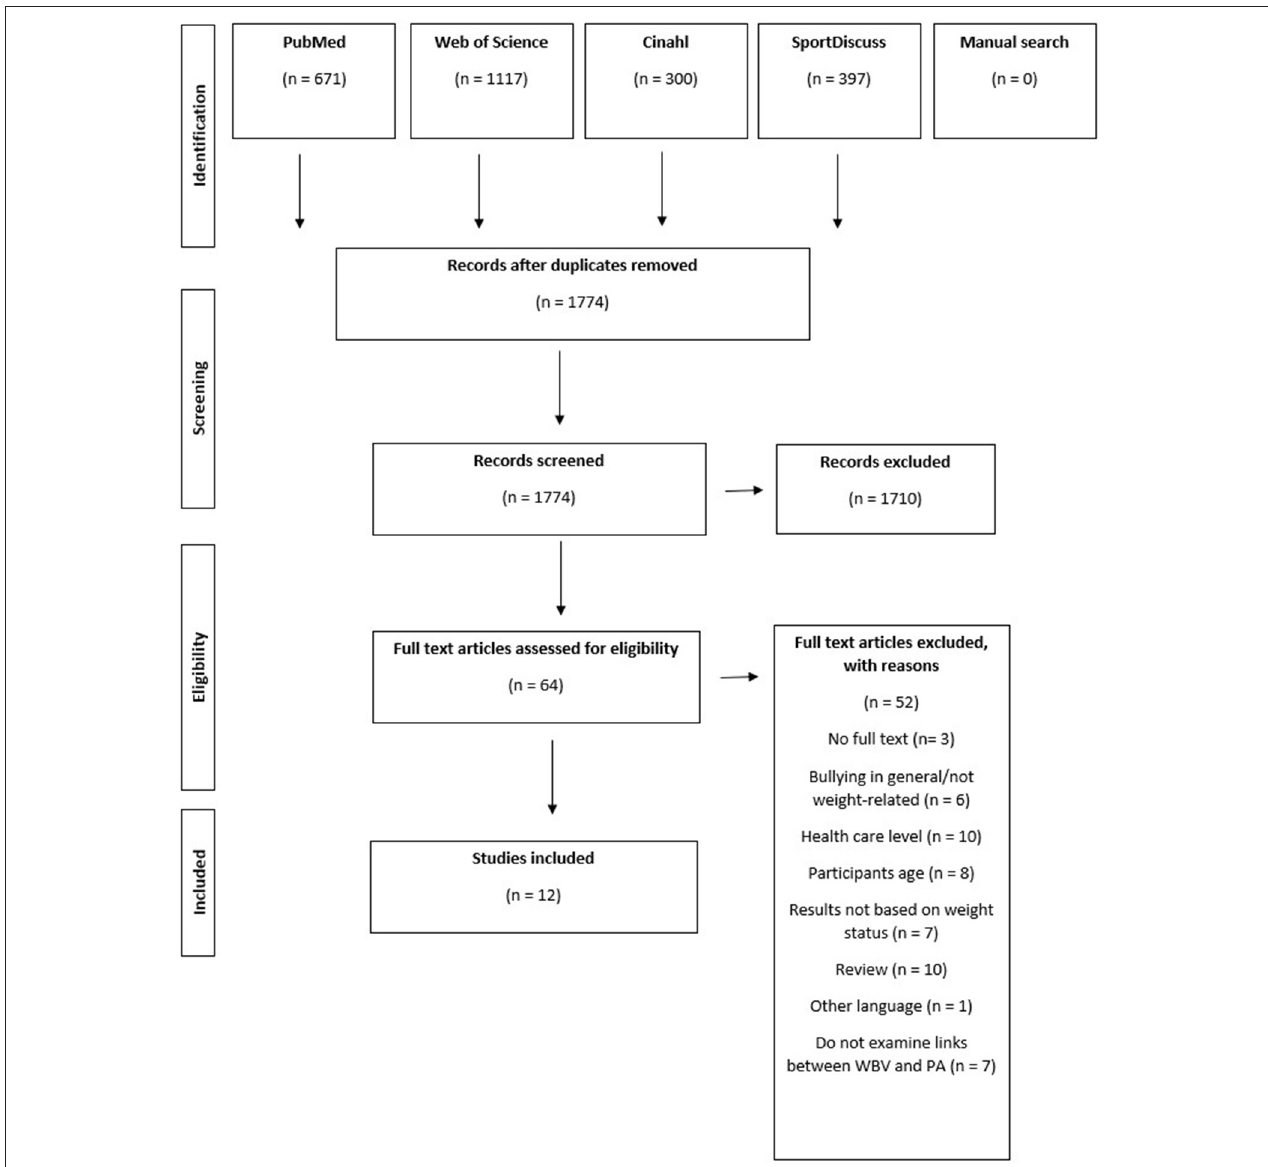
FIGURE 1 | Flowchart diagram of the screening and selection